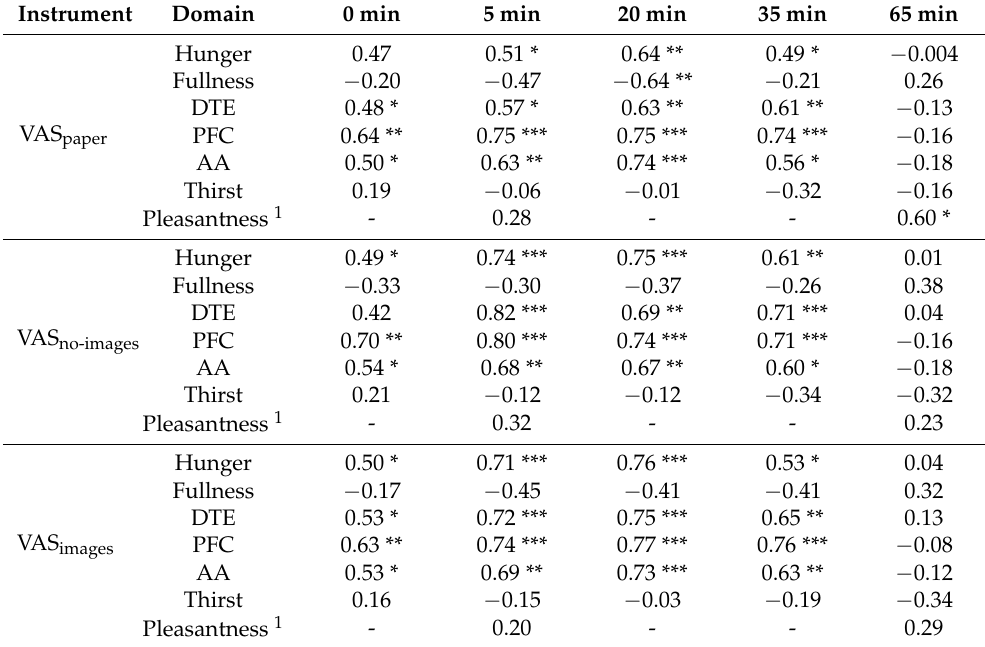
Figure 3. Agreement between three VAS instruments at five time points for: ( A ) hunger, ( B ) fullness, ( C ) desire-to-eat, ( D ) prospective food consumption, ( E ) average appetite, and ( F ) thirst. All values are means ± SEM, n = 17 ( n = 9 girls, n = 8 boys). Two-way ANOVA revealed no instrument by time interaction ( p > 0.58), and no main effect of instrument ( p > 0.31), but a main effect of time ( p < 0.001). Table 3. Pearson correlations evaluating predictive validity of the three VAS instruments on next-meal food